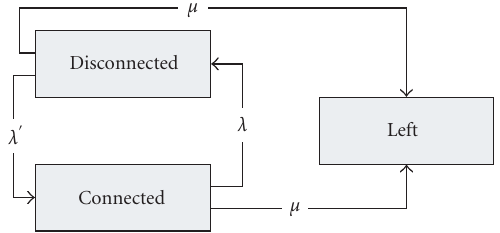
Figure 7: State model of data storage without maintenance.